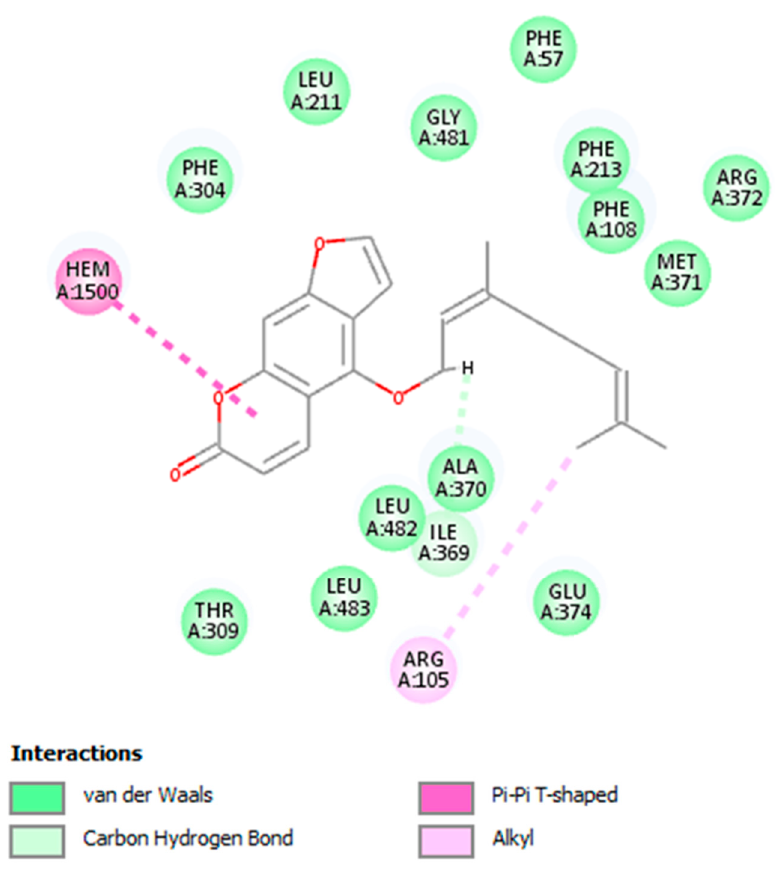
Figure 8. 2D diagram for bergamottin–amino acid interactions from pose 5.